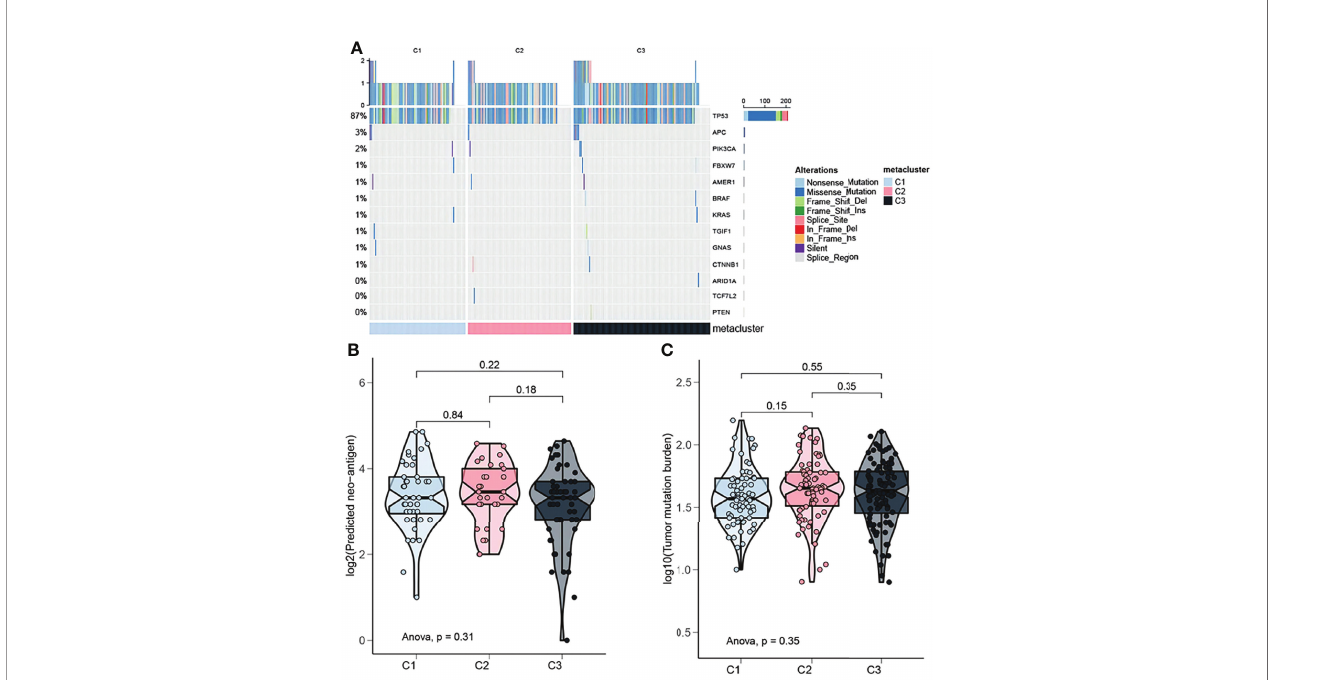
FIGURE 5 | Mutation landscape of OV subtypes. (A) Oncoplot showing the distribution of mutated genes in the identi fi ed OV subtypes. (B) Proportion of neoantigens in the different subtypes. (C) Proportion of tumor mutation burden in the different